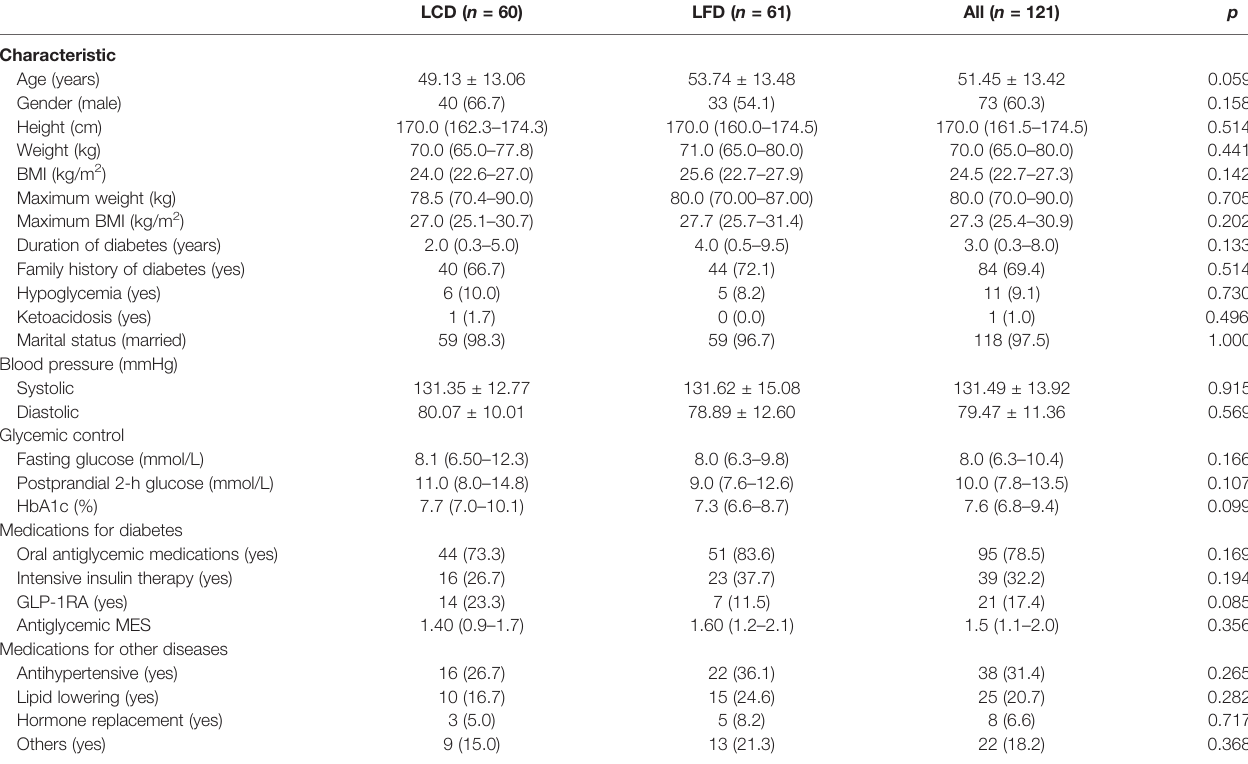
TABLE 2 | Baseline characteristics of the study